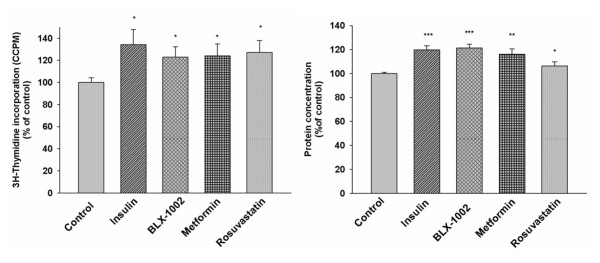
Insulin, BLX-1002, metformin and rosuvastatin stimulate HCAEC proliferation at normal glucose concentration. In order to study the effects of agents on proliferation of HCAECs, cells were incubated at 5 mM of glucose in medium supplemented with 0.5% FBS for 24 h in the presence or absence of insulin lispro (100 pM), metformin (500 μM), BLX-1002 (1 μM), rosuvastatin (10 nM). Eight hours prior to the end of the incubation, cells were pulsed with [3H]thymidine. Cells were then harvested and [3H]thymidine incorporation into DNA was measured using a microplate scintillation & luminescence counter, and the protein concentration of the samples was measured using DC™ Protein Assay. * denotes P < 0.05, ** denotes P < 0.01, *** denotes P < 0.001 for chance differences vs. controls by Student's t-test.